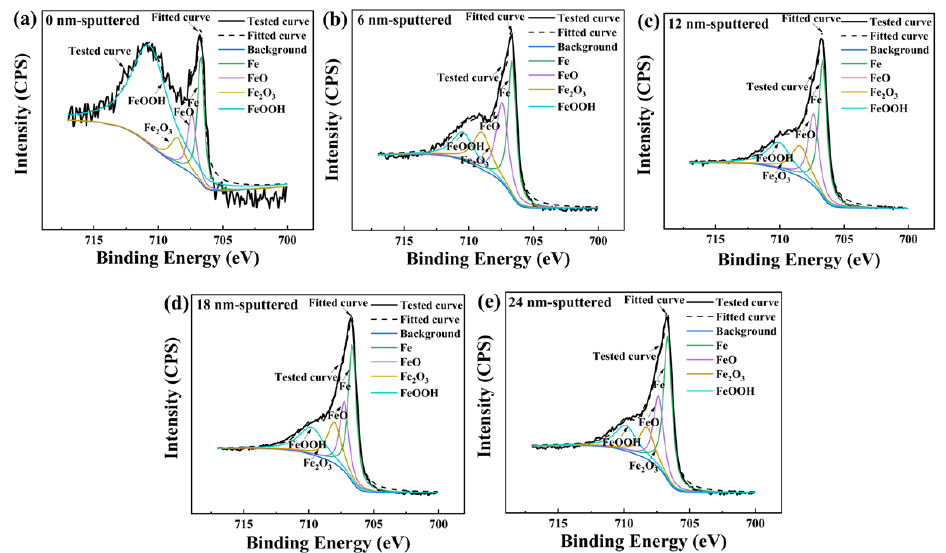
Figure 10. XPS depth analysis of Fe 2p 3/2 at ( a ) 0 nm, ( b ) 6 nm, ( c ) 12 nm, ( d ) 18 nm, and ( e ) 24 nm of the passive film of SNC rebar. Table 5. Fe 2p 3/2 spectral fitting parameters: binding energy (eV), FWHM value (eV), and area ratio (%).